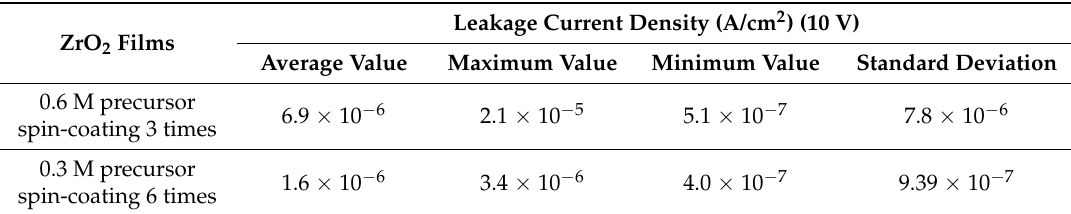
Figure 10. The leakage current density of each feature point on the ZrO 2 film. ( a ) 0.3 M precursor spin-coating 6 times. ( b ) 0.6 M precursor spin-coating 3 times. Table 3. The statistics of electrical properties of each feature point.